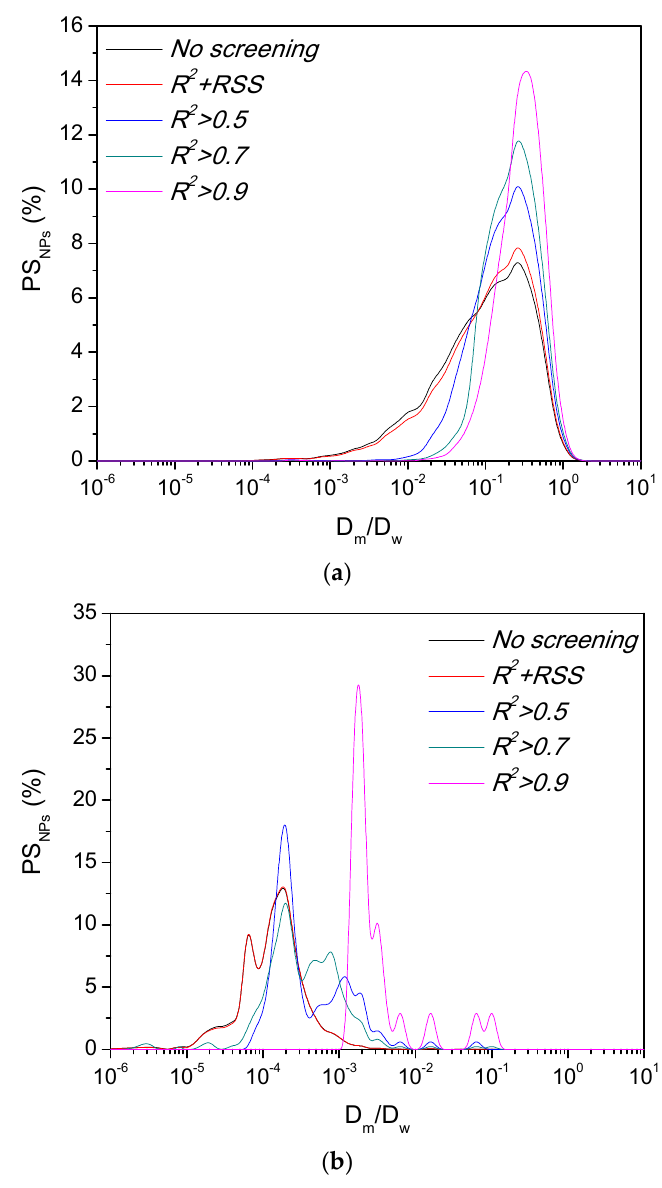
Figure 8. Particle populations considered to calculate the diffusion capacity of ( a ) diffusive PS NPS control and ( b ) adhesive PS NPS control after following different approaches to evaluate the